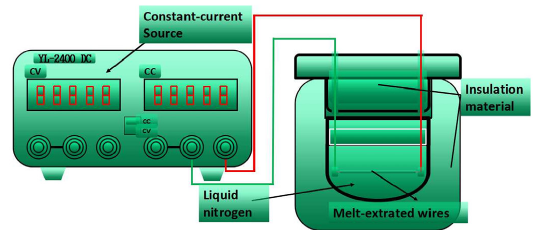
Figure 1. Schematic illustration of CJA process with insulation material and the microwire surrounding by nitrogen gap during annealing